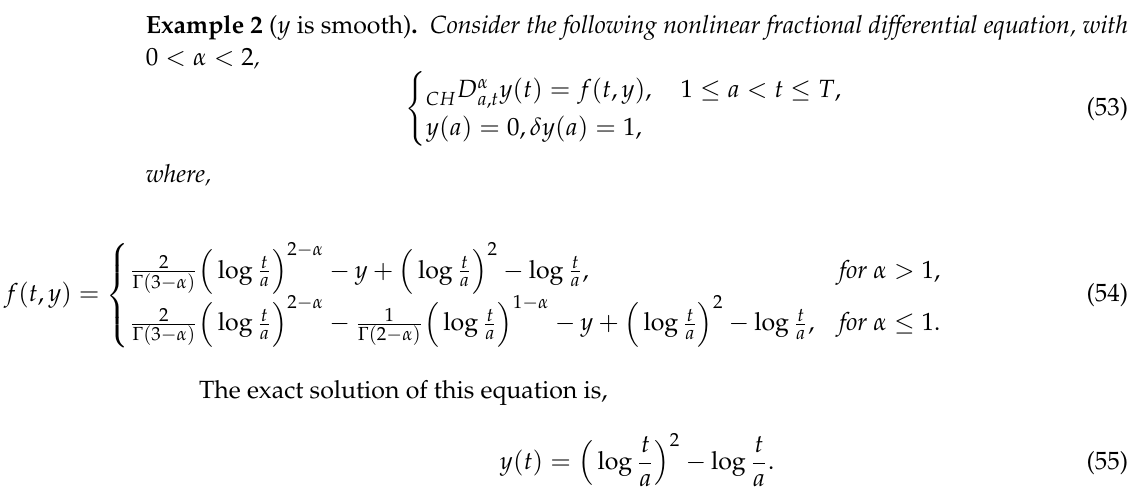
Figure 2. Graph showing the experimental order of convergence (EOC) at T = 2 in Example 1 with α =